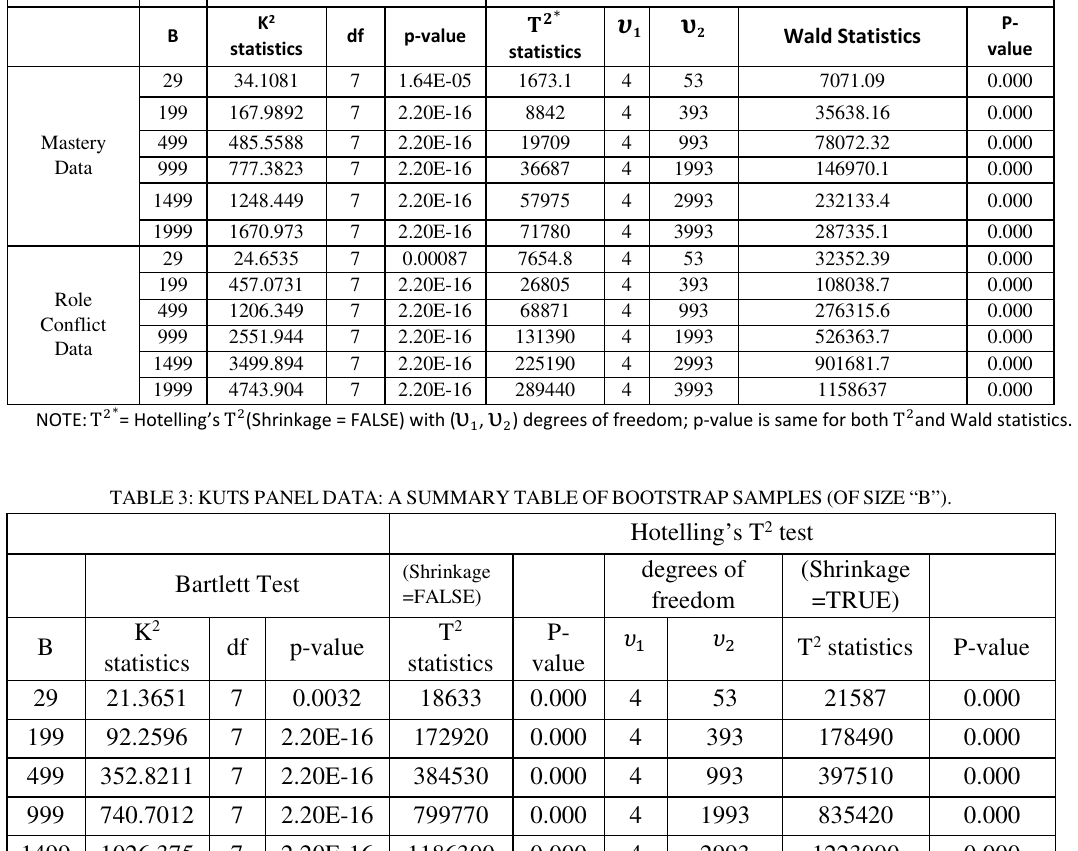
TABLE 2: A SUMMARY TABLE OF BOOTSTRAP SAMPLES (OF SIZE “B”) FOR MASTERY AND COLEMAN’S PANEL DATA. Bartlett Test